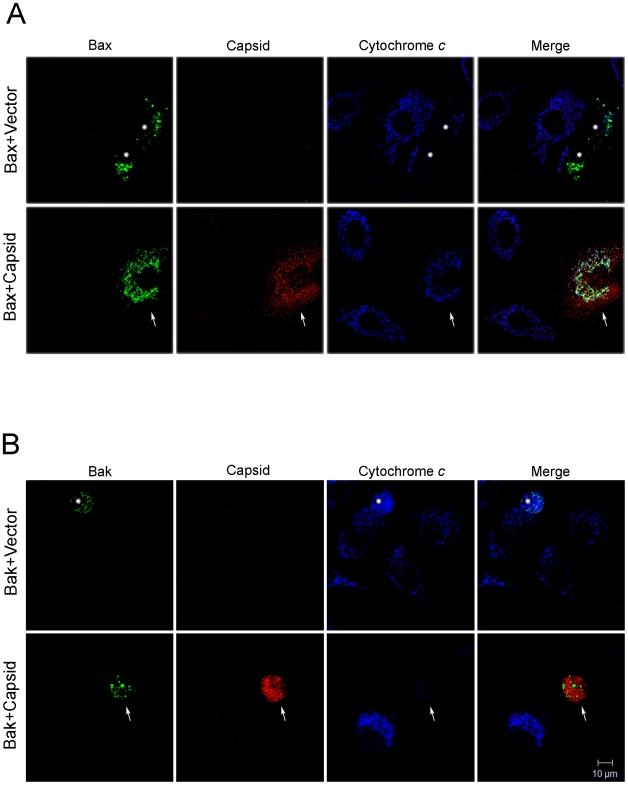
Capsid expression prevents Bax-induced release of cytochrome c from mitochondria.A549 cells were co-transfected with plasmids encoding capsid or vector alone together with GFP-Bax (A) or GFP-Bak (B). After 24 hours, cells were stained with mouse anti-capsid and rabbit anti-cytochrome c. Primary antibodies were detected with chicken anti-mouse Alexa594 and donkey anti-rabbit Alexa637. Asterisks mark Bax or Bak expressing cells that have released their mitochondrial stores of cytochrome c into the cytoplasm. In part A, the arrows denote a cell expressing both capsid and Bax. In this cell, it can be seen that cytochrome c remains associated with mitochondria. In part B, the arrowheads denote a cell expressing both capsid and Bak. However, in this case, the cell has released its mitochondrial stores of cytochrome c into the cytoplasm. Images shown are representative of three independent experiments in which at least 100 cells were examined. Scale bar  = 10 µm.